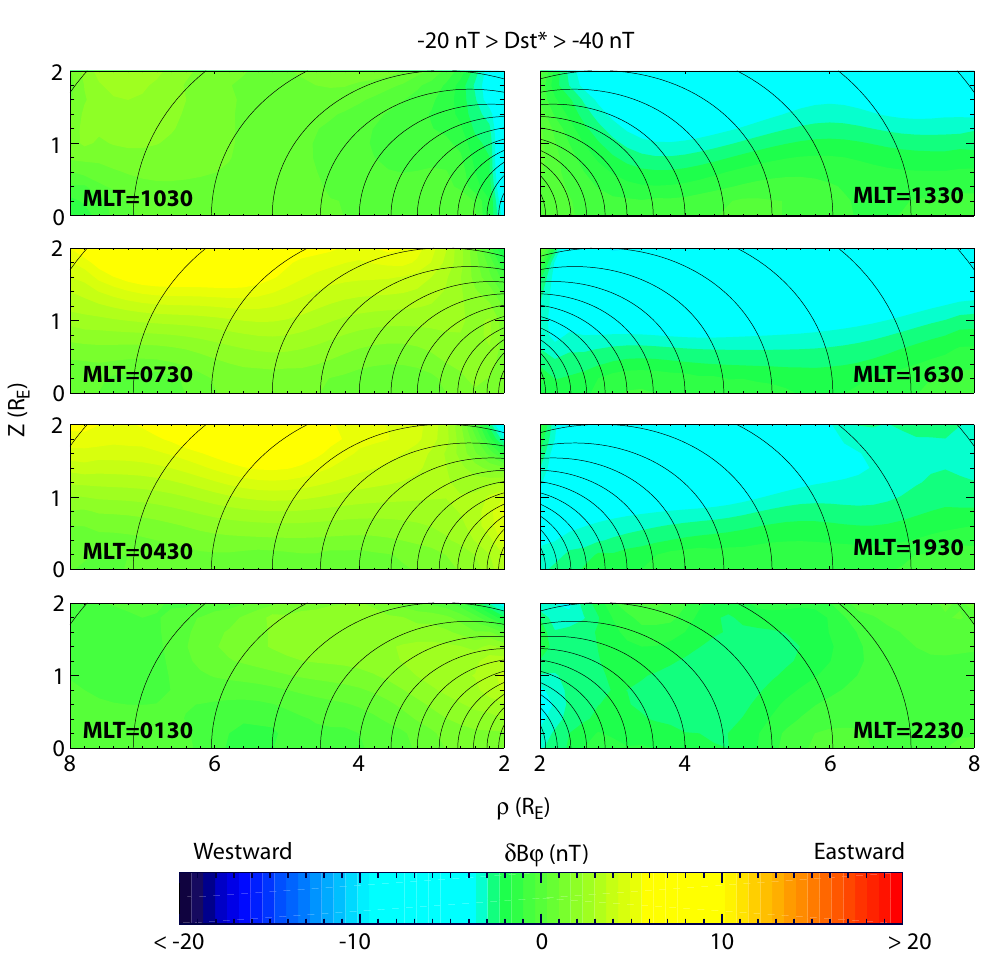
Fig. 5a. Azimuthal component of perturbation magnetic field with superimposed dipole field lines in each of the 8 magnetic local time bins and for each of the four D st * ranges. Only the northern meridian plane is shown. The southern part is anti-symmetric to the northern part: (a) − 20nT >D st * > −